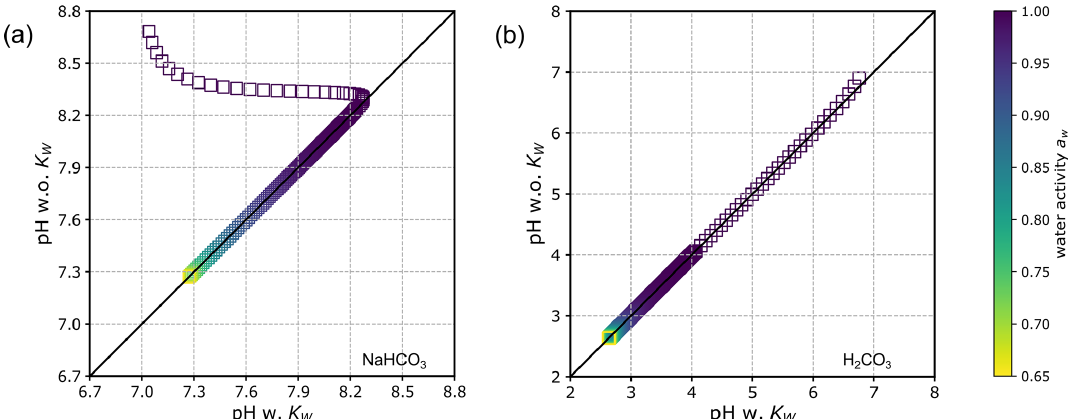
Figure 10. Comparison of calculated pH for the same input solution compositions but with ( x axis) or without ( y axis) the consideration of the equilibrium auto-dissociation of water (H 2 O (cid:10) H + + OH − ). (a) Aqueous NaHCO 3 and (b) aqueous H 2 CO 3 solutions at 298.15K. Color axis: equilibrium water